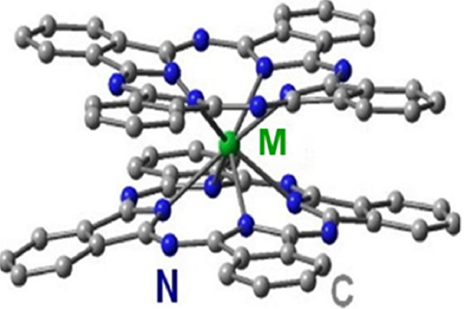
Figure 1. Diphthalocyanine molecule with a metal atom (M = Eu) linking plane organic ligands via nitrogen atoms.